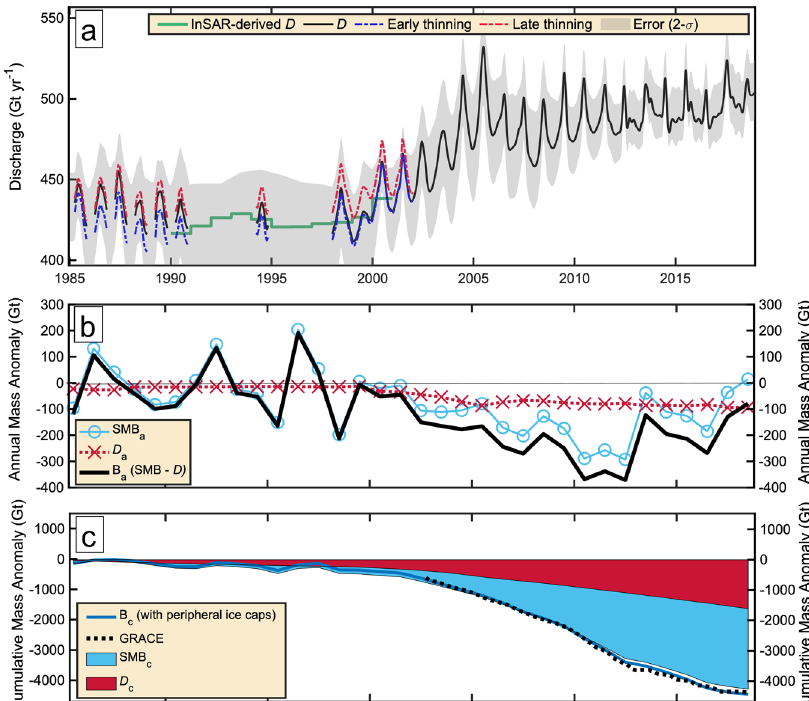
Fig. 1 Net ice sheet discharge at contributions to total mass balance. a Total GrIS discharge (black curve) with early (blue) and late-thinning (red dashes) scenarios between 1985 and 1999, and discharge estimates derived from wintertime InSAR velocities from Mouginot et al. 4 in green. Gray shading is 2- σ uncertainty. b Net annual mass balance ( B a , black curve), annual surface mass balance (SMB a , blue dashes with circles) and total annual discharge ( D a , red dashes with crosses). c Total shading shows the cumulative mass anomaly ( B c ) of B a since 1985 broken into cumulative contributions from discharge ( D c , red) and surface mass balance (SMB c , blue). B c including SMB from peripheral ice caps, to match the GRACE domain, is plotted by dark blue line. GRACE estimates, updated from Wouters et al. 16 for the 2002 – 2018 time period, are also plotted on this axis as a moving 12-month average (dotted black), and shifted along the y -axis to begin at the 2002 B c